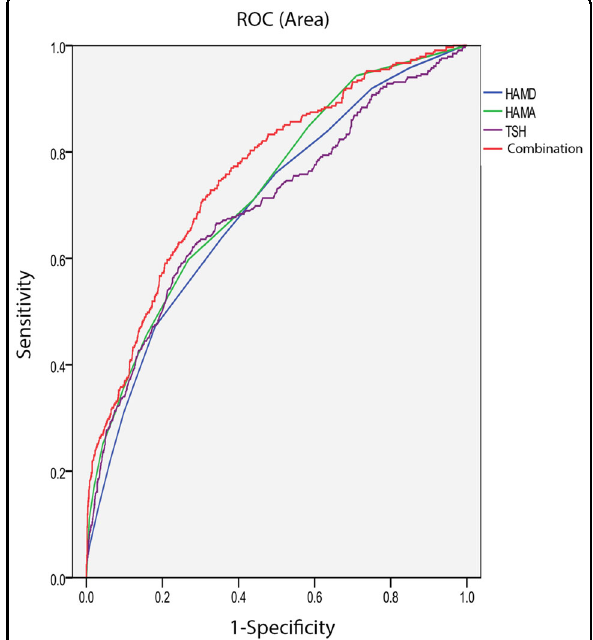
Fig. 1 The discriminatory capacity of related factors for distinguishing between patients with and without suicide attempts in MDD comorbid with anxiety symptoms. The area under the curve of HAMD score, HAMA score, TSH, and the combination of these three factors were 0.70, 0.73, 0.70, and 0.76,